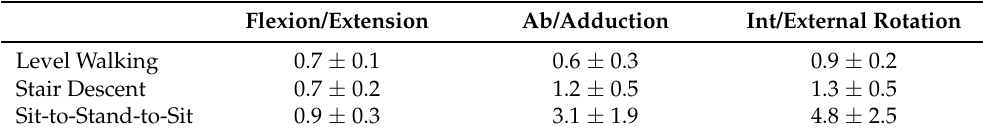
Table 1. Root-mean-square error (in degrees) between sensor-estimated kinematics and simulator- generated ground truth data was calculated over one cycle of every activity, for each of the six subjects. Results are summarised by expressing mean RMSE, ±1 standard deviation, over all subjects, for each of the three planes of